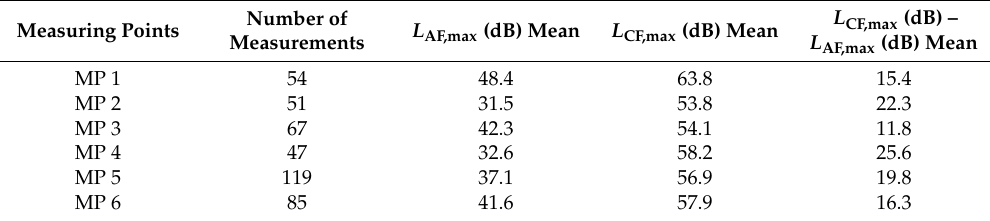
Table 1. Noise exposure (Maximum-SPL A- and C-weighted) of analyzed tramways.